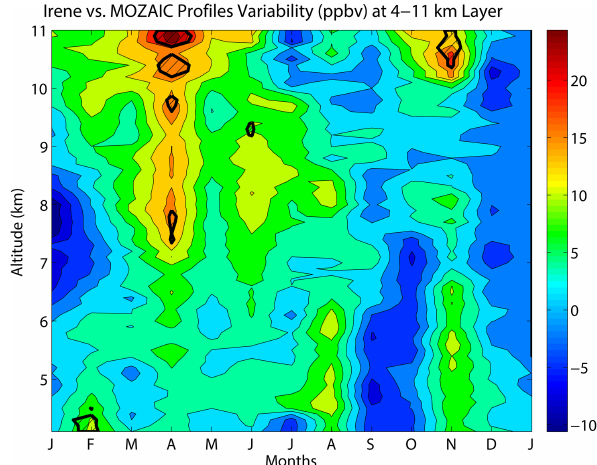
Figure 5. Difference between Irene ozonesonde climatology com- bined from 1990 to 1993 and 1999 to 2007 and MOZAIC climatol- ogy from 1995 to 1999. Hatched areas represent statistically signif- icant deviations of climatologies (places where standard deviation values from two climatologies do not